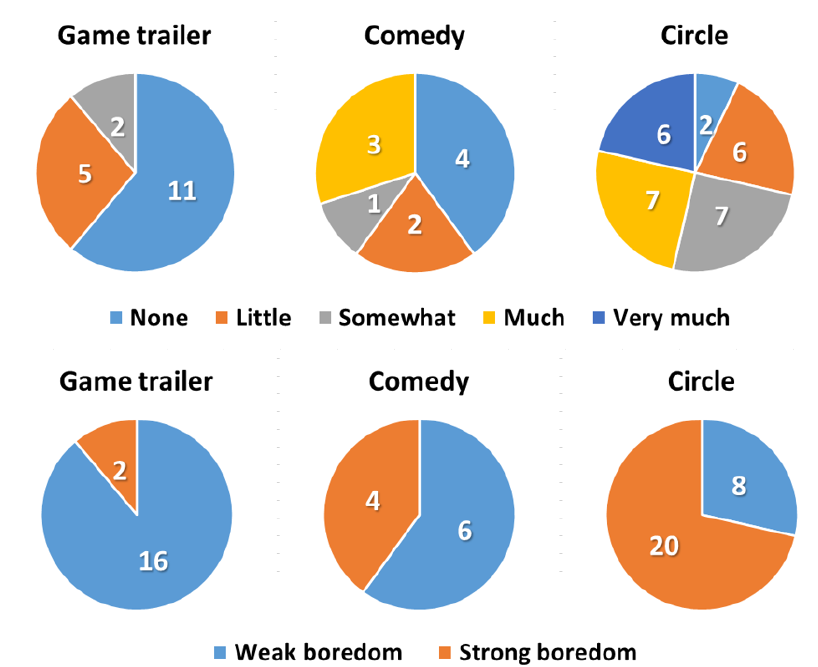
Figure 4. Questionnaire results (Question: How much boredom did you feel from “stimulus name”?).